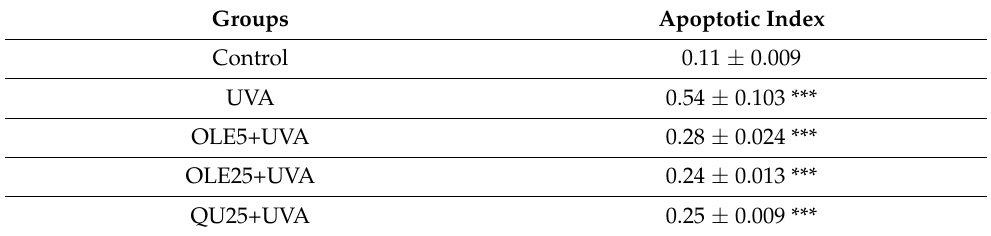
Table 2. Effects of OLE treatment on UVA-induced apoptosis of Hs68 cells.